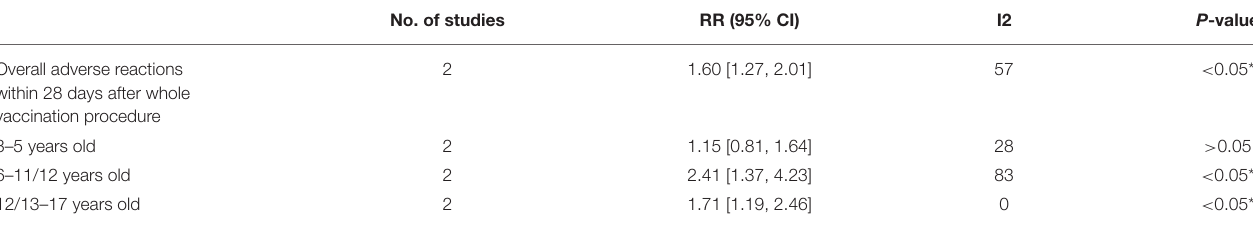
TABLE 7 | Overall adverse reactions within 28 days after whole vaccination procedure in inactivated vaccine group of different ages vs. control group. No. of studies I2 P -value Overall adverse reactions within 28 days after whole vaccination